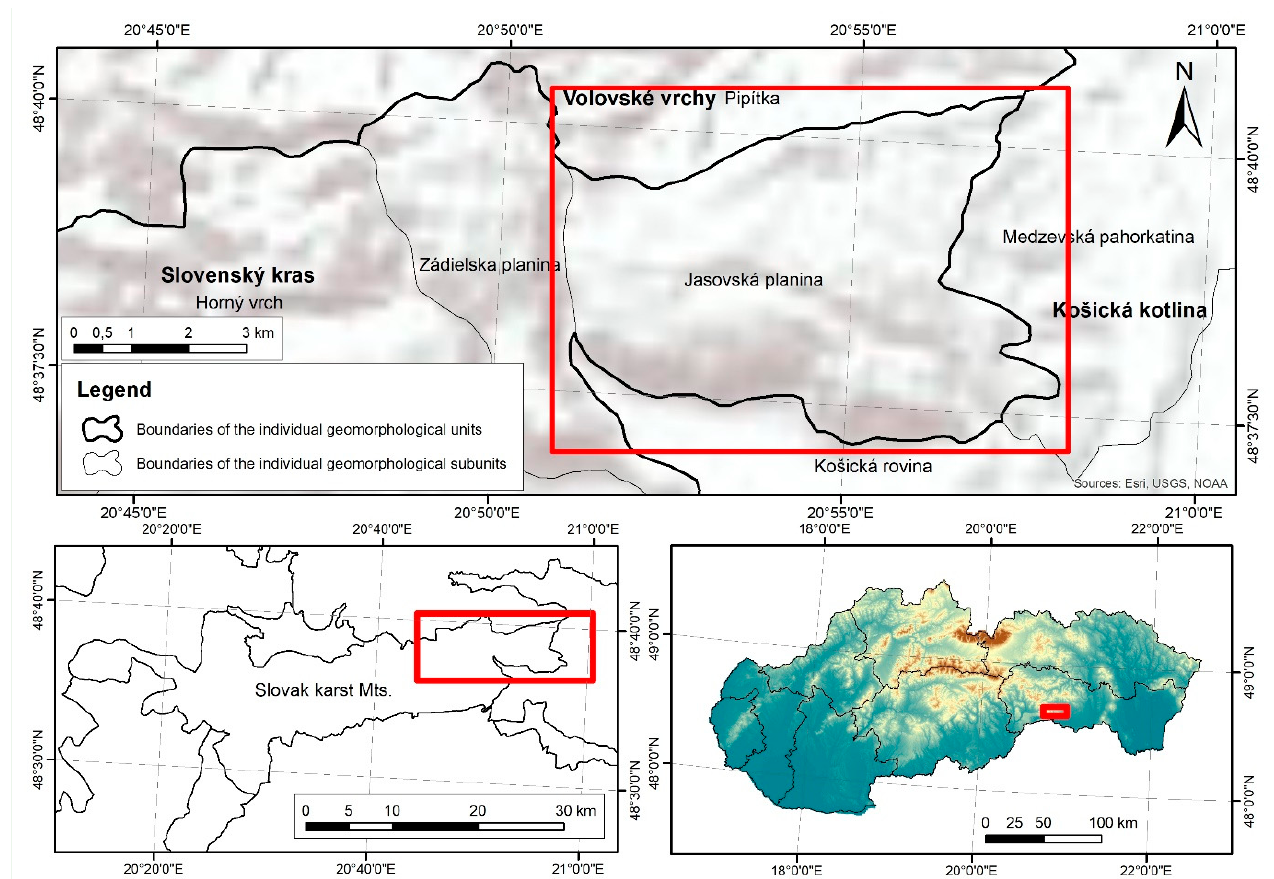
Figure 1. Position of the study area within Slovakia, Slovak Karst, and Jasov Plateau.